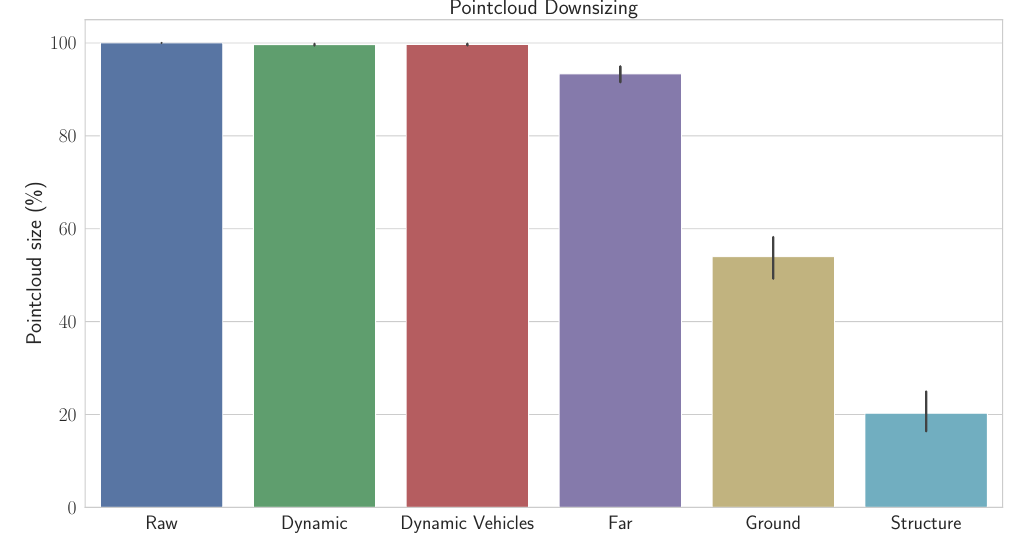
Figure 2. Point cloud downsizing with each of the tested